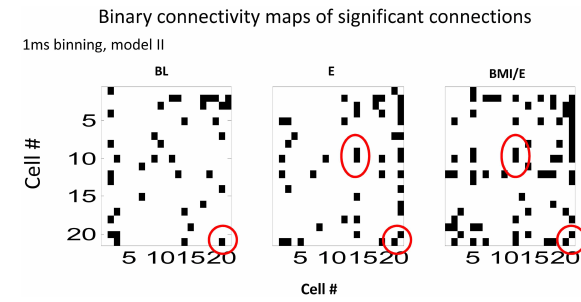
FIGURE 4 | Binary connectivity maps from the GLM fits in a typical session (from the same session as is shown in Figure 5). Significant connections are shown in black. The networks showed sparse connectivity. The connection density was higher for the 1ms bin time scale that is shown (1ms binning). Examples of a few connections found in common in the GLM fits in each condition, are circled in red. These show consistency in modeling of some connections across all the conditions. Abbrevations: BL, baseline; E, elastic load; BMI/E, brain machine interface and elastic load.